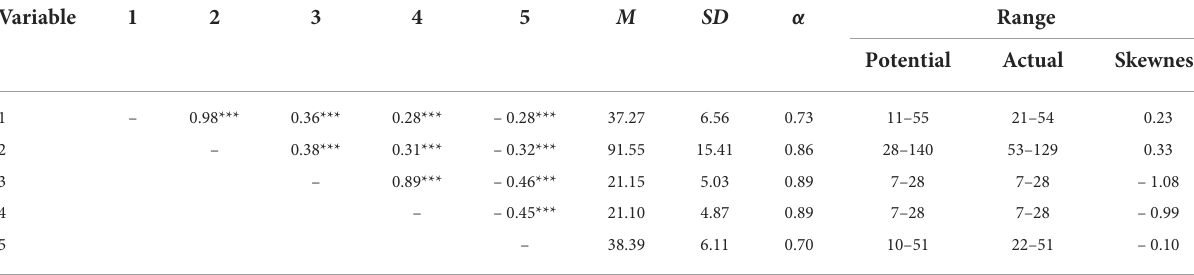
TABLE 1 Psychometric properties and Pearson correlation among variables.